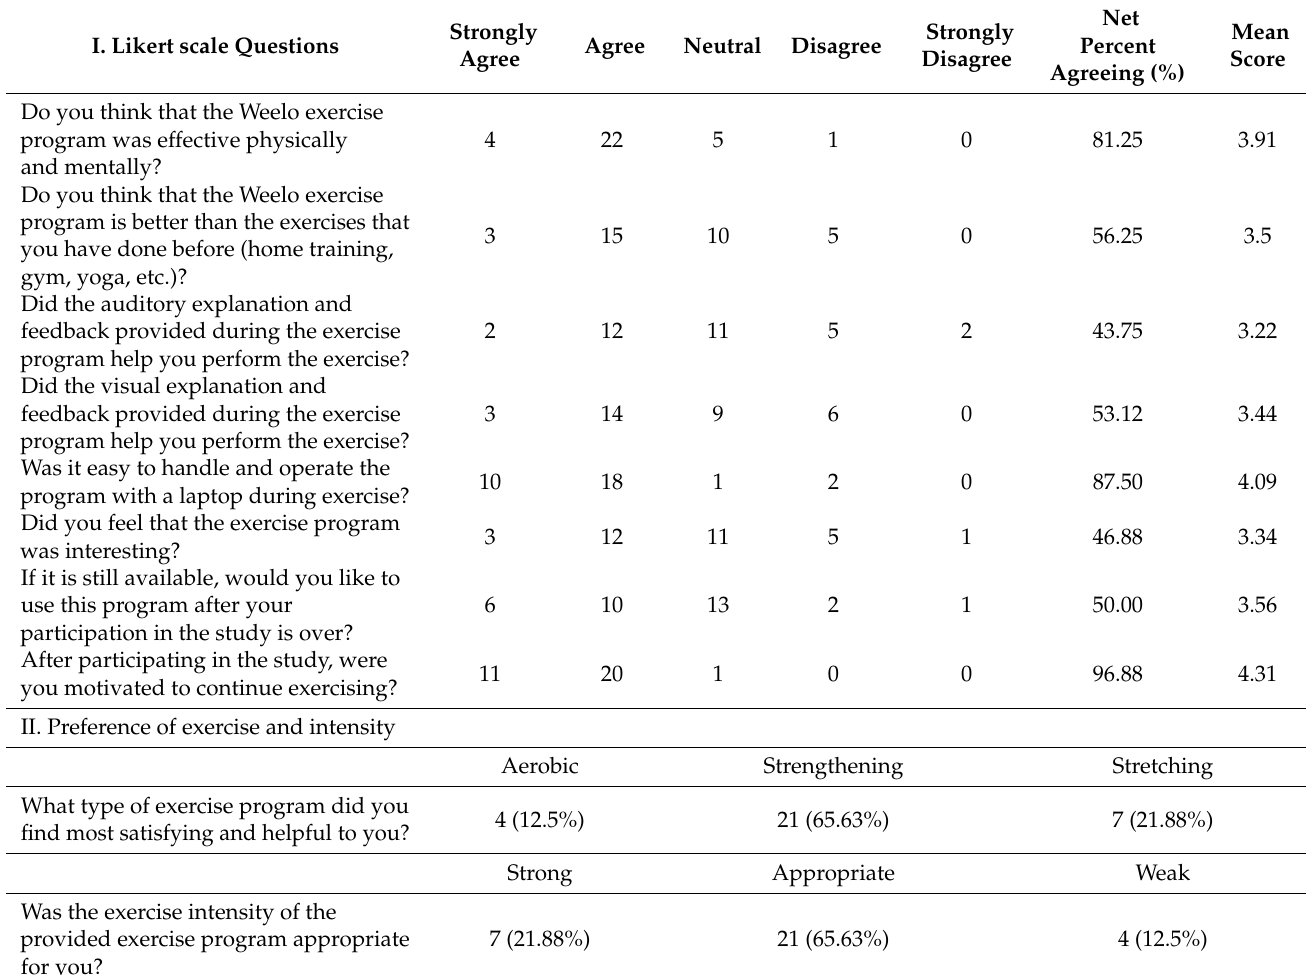
Table 4. Satisfaction survey results for